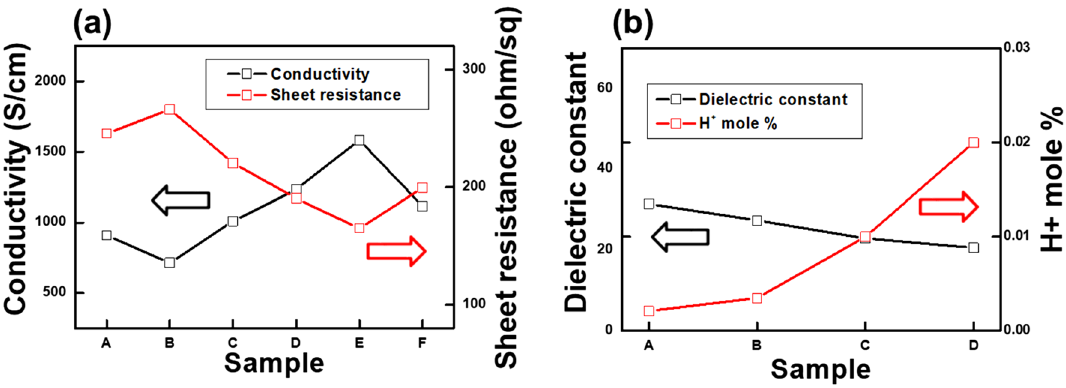
Figure 2. ( a ) Sheet resistances and conductivities of the PEDOT:PSS films with DMSO, methanol and benzoic acid treatments, and ( b ) the dielectric constants and the H + mole % of benzoic acid solution with various weight concentration of the benzoic acid (Kang et